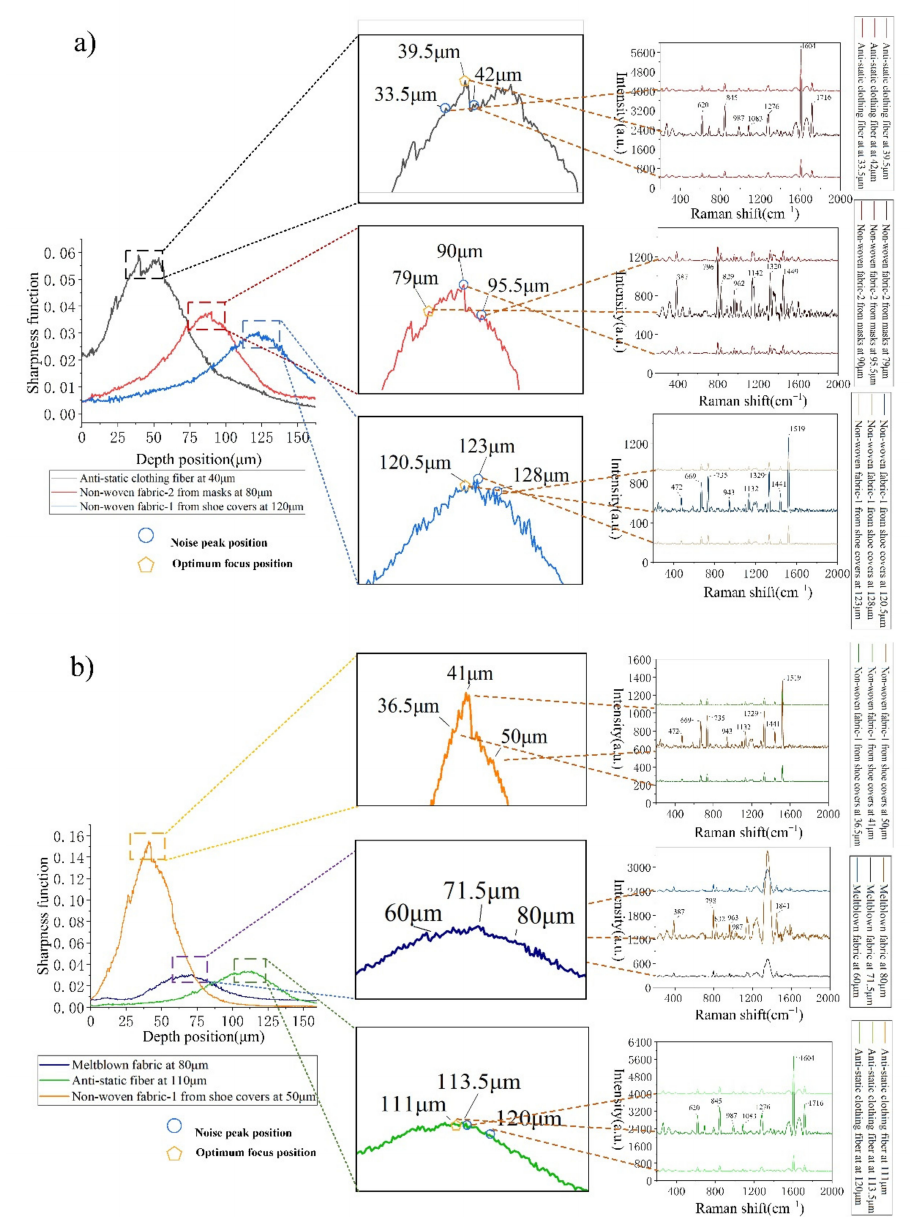
Figure 9. Sharpness evaluation function of three different kinds of fibers at different positions and related Raman spectrum acquired at these different positions; ( a ) is the result of the first sample, and ( b ) is the result of the second